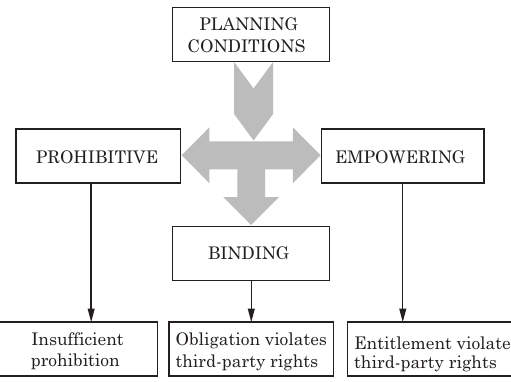
Figure 3. Classification of the planning